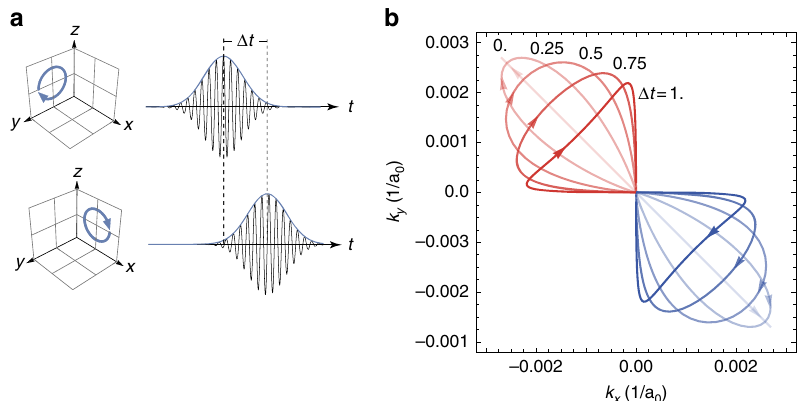
Figure 3 | Dynamical Floquet–Weyl points. ( a ) Floquet TDDFTpredicts that the position of the Floquet–Weyl points can be controlled in real time on the timescale of pulse envelopes, yielding a time-dependent band structure that is accessible through time- and angle-resolved photoemission spectroscopy. Two time-delayed ( D t ) pump laser pulses, circularly polarized in y – z and x – z directions, respectively, drive the Floquet–Weyl points in the k x – k y plane of the BZ. ( b ) The varying field strength during the laser pulses leads to dancing Floquet–Weyl points with trajectories controlled by D t given in units of the FWHM of